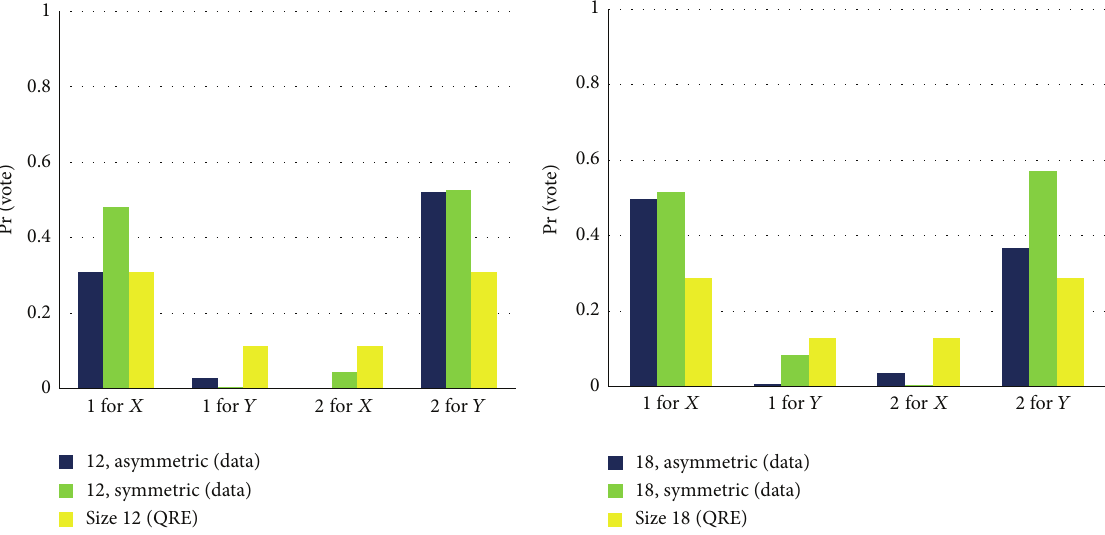
Figure 3: QRE versus data, rounds 11–20.